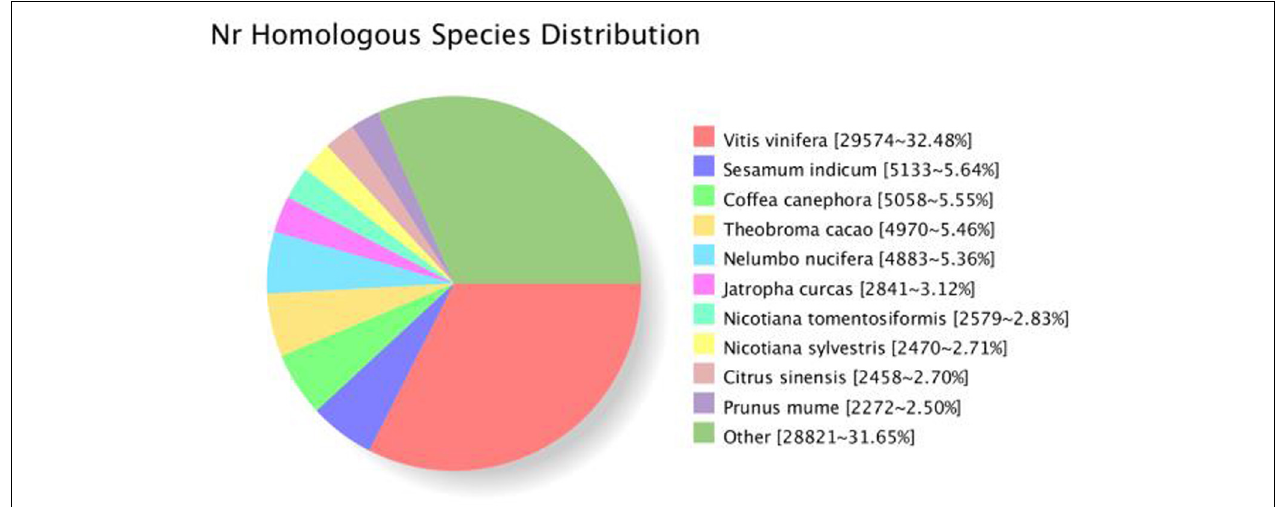
FIGURE 5 | Species distribution of S. superba transcriptome annotated in the Nr database.